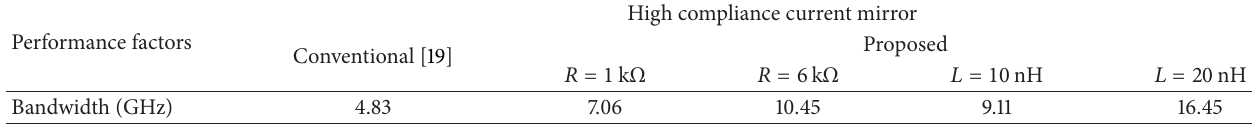
Table 4: Bandwidth comparison of conventional and proposed current